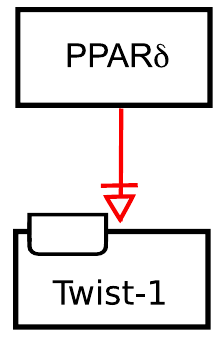
Figure 2.20: The Activity Flow glyph for necessary stimulation .